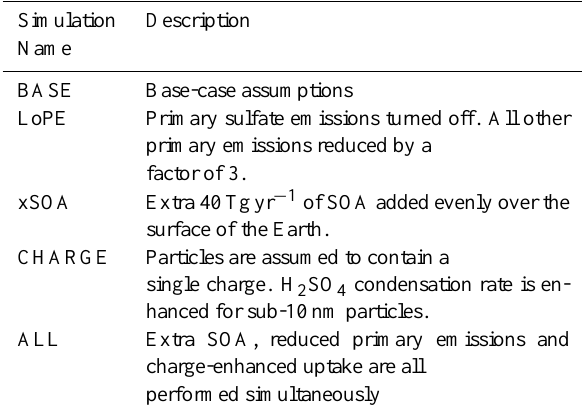
Table 1. Summary of various sensitivity